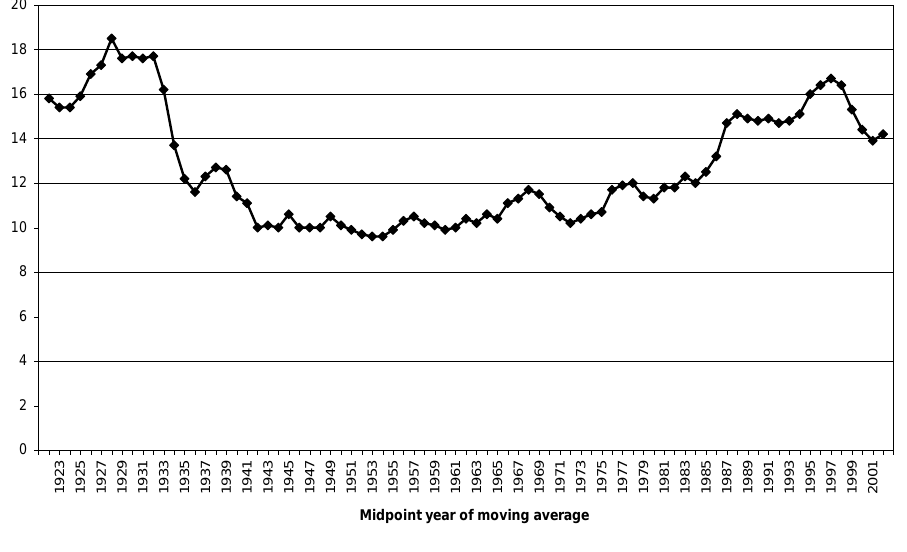
FIGURE 1. Age-standardised suicide rates, 3-year moving averages, 1921–2003. Source : New Zealand Health Information